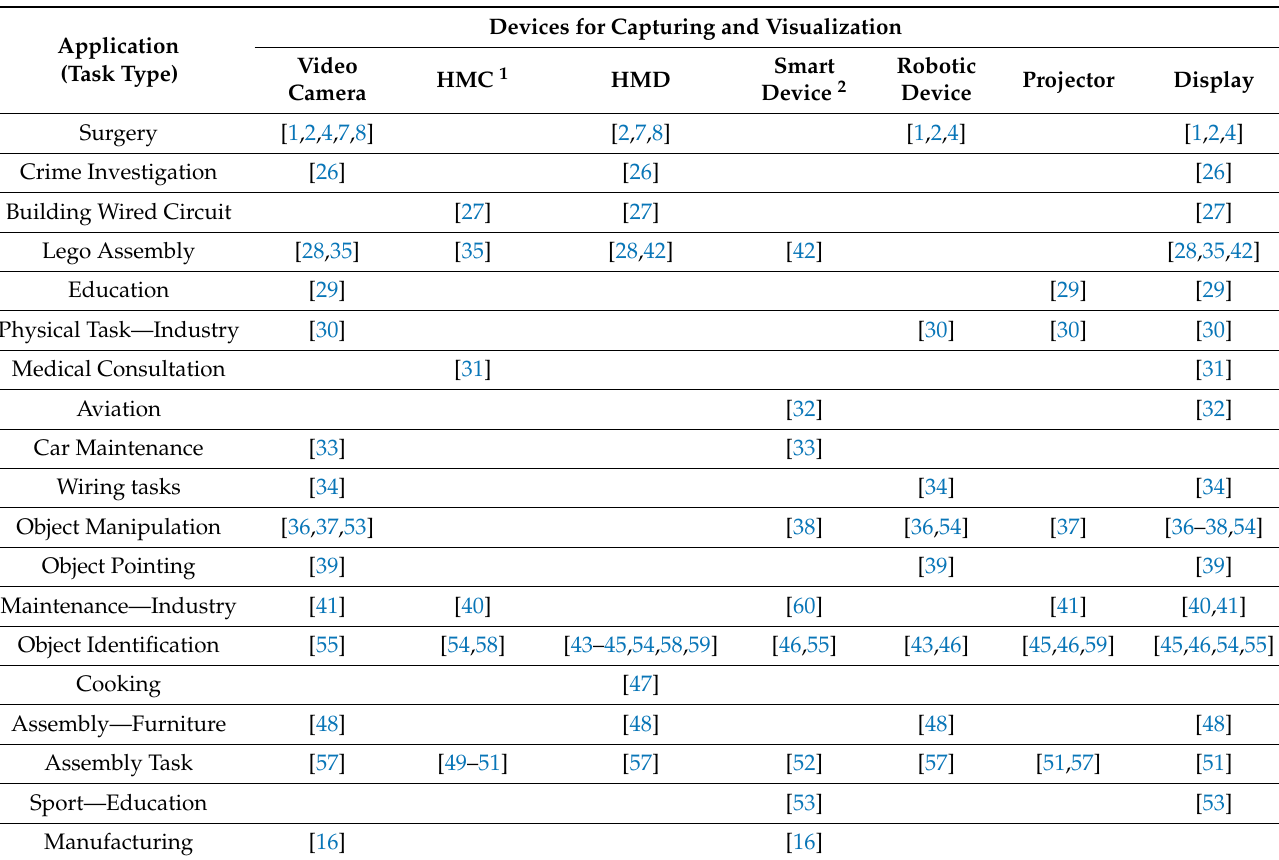
Table 1. Devices and components for remote collaboration